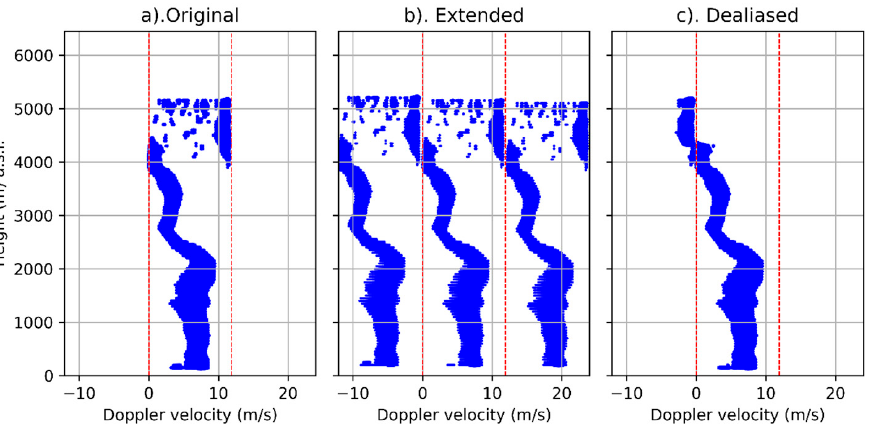
Figure 5. Example of Doppler velocity dealiasing applied with RaProM- Pro compared to the original data (16 May 2020, 13:45 UTC). Original Doppler spectra profile ( a ), extended Doppler spectra profile ( b ) and final dealiased Doppler spectra profile ( c ).